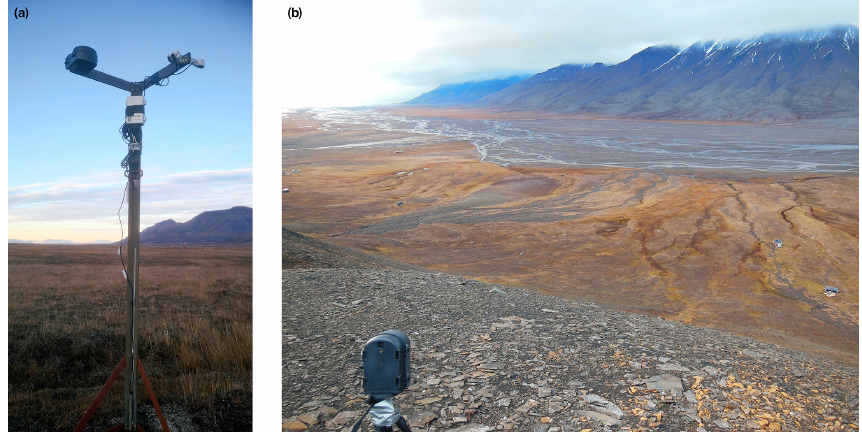
Figure 2. Overview photographs of (a) rack 8 mounted with a WingScapes camera (on the left arm) and Decagon NDVI sensors, both incoming and reflected (on the right arm), and (b) a WingScapes camera on top of Breinosa overlooking the area with racks 1 to 5. The picture of the rack was taken in mid-October 2017, and the overview photo of the mountain camera was taken in mid-September 2016. In both photographs, the vegetation had senesced, hence the brown colour. Table 3. Equipment installed at each rack from 2015 to 2018 (GW: GardenWatchCam; WS: WingScapes). Rack 1 switched from a Garden- WatchCam to a WingScapes during the 2017 field season, which is why both are indicated. Soil moisture was not recorded in 2016 due to equipment